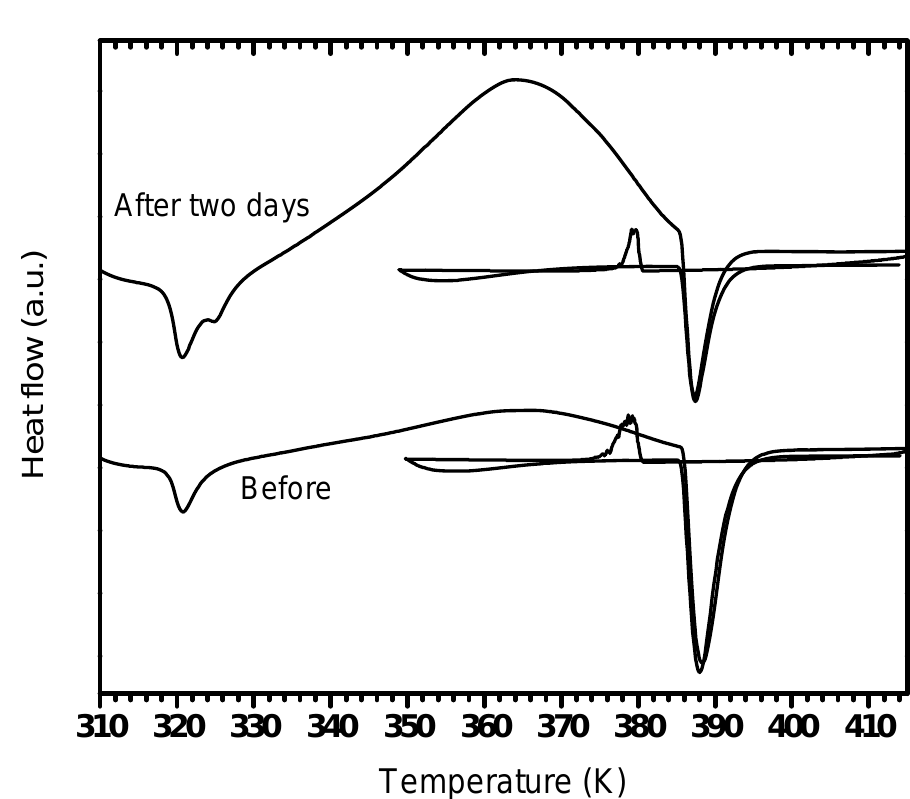
Figure 4. Scanning PDSC traces under argon of unmilled LiBH of storage in a glove box. Heating and cooling rates: 20 K min –1